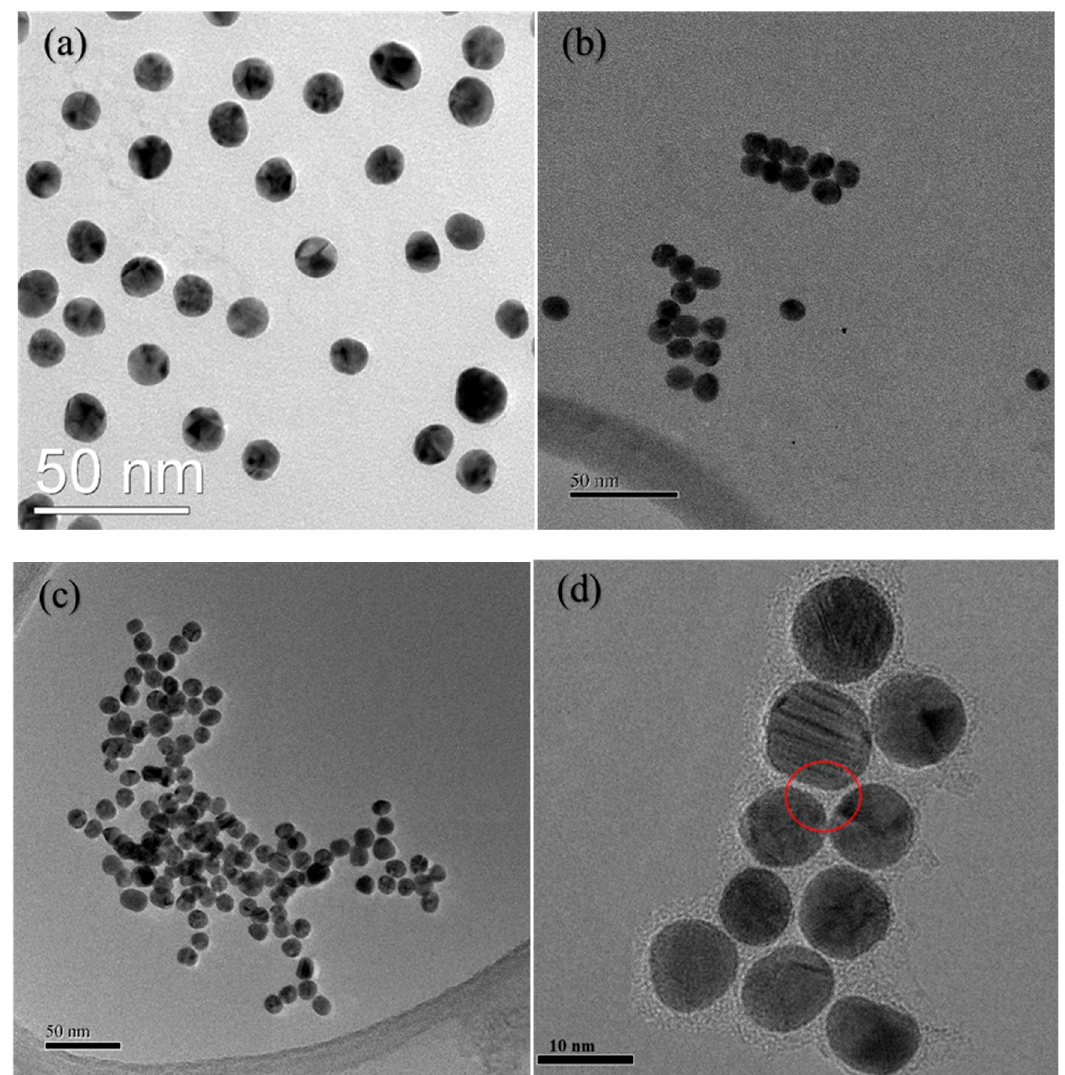
Figure 7. TEM images of conjugated gold–porphyrin nanostructures: ( a ) Au nanoparticles obtained from the reduction of the tetrachloroauric acid with sodium citrate; ( b ) Au NPs obtained from 100 µ L of an Au NPs aqueous 1.97 × 10 − 7 M solution diluted with 2 mL of CH 3 OH upon the addition of 240 µ L of a 2.07 × 10 − 5 M porphyrin CH 3 OH solution; ( c ) Au NPs obtained from 100 µ L of an Au NPs aqueous 1.97 × 10 − 7 M solution diluted with 2 mL of CH 3 OH upon the addition of 450 µ L of a 2.07 × 10 − 5 M porphyrin CH 3 OH solution; ( d ) higher magnification of the Au NPs obtained from 100 µ L of an Au NPs aqueous 1.97 × 10 − 7 M solution diluted with 2 mL of CH 3 OH upon the addition of 450 µ L of a 2.07 × 10 − 5 M porphyrin CH 3 OH solution; the red circle represents the representative area investigated with EDX to obtain Figure